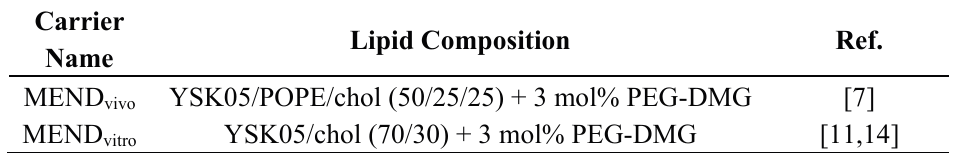
Table 1. Lipid composition of MEND vivo and MEND vitro